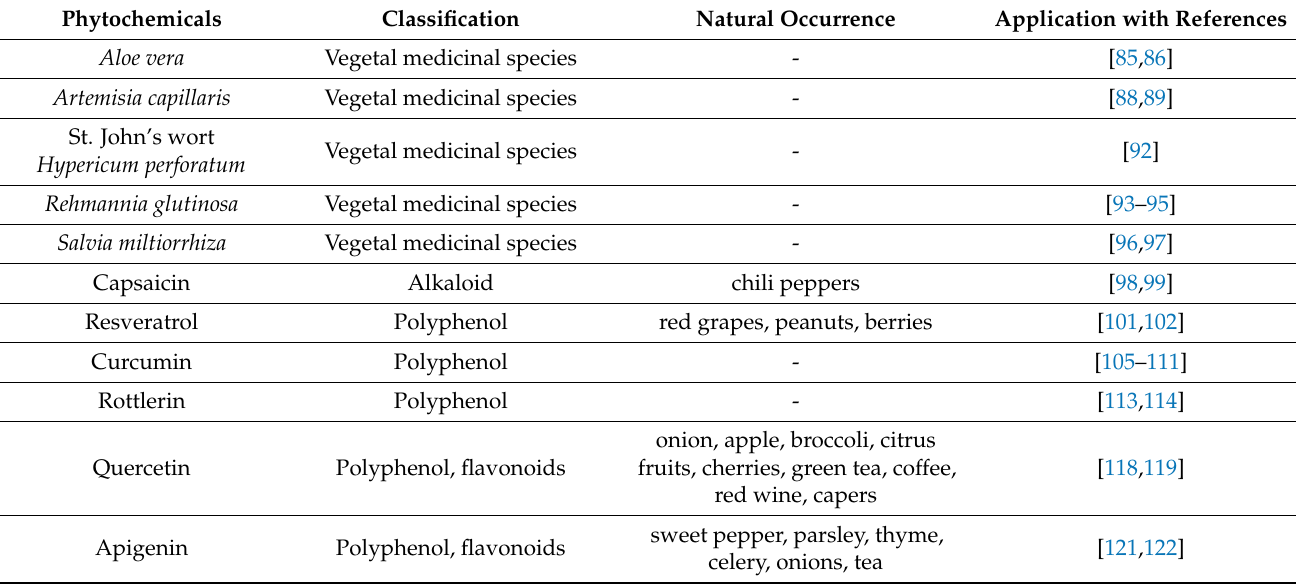
Table 1. The table presents different chosen plants and phytochemicals with their